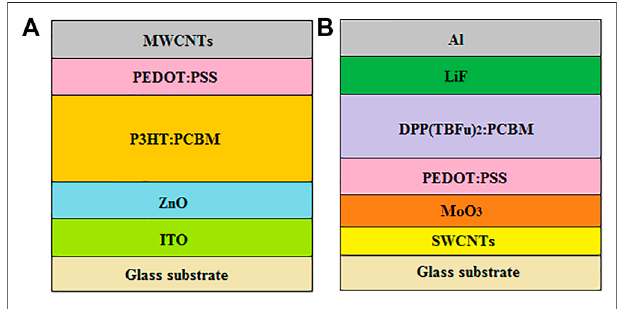
FIGURE 3 | Schematic diagram of (A) an inverted OSC based on a MWCNT anode and (B) a conventional OSC based on a SWCNT anode.